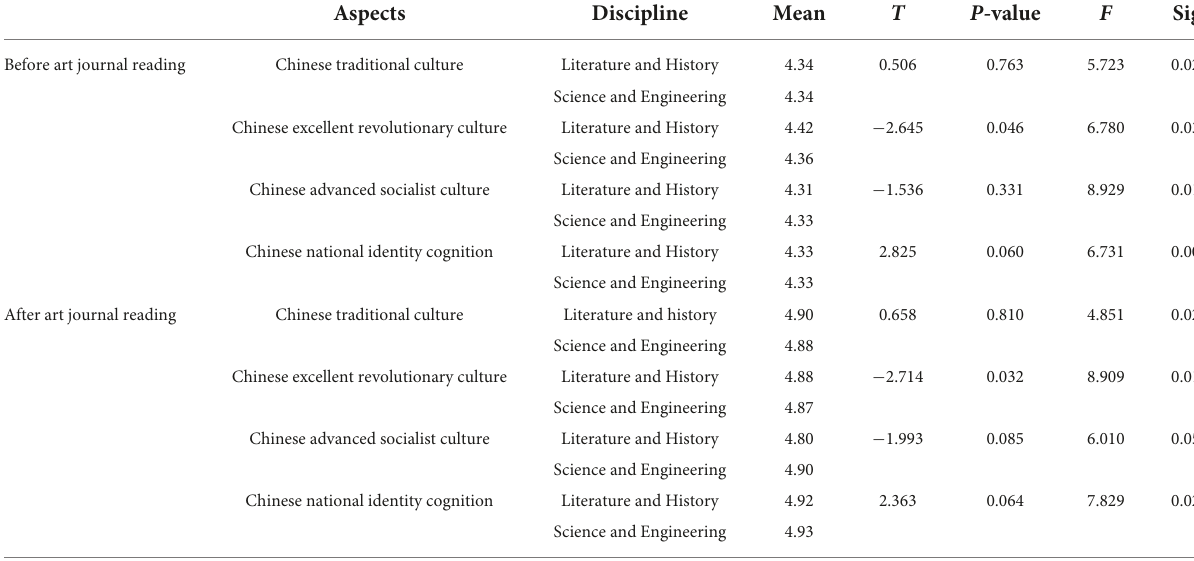
TABLE 5 Comparison of the national cognition and cultural acceptance of college students in different majors.